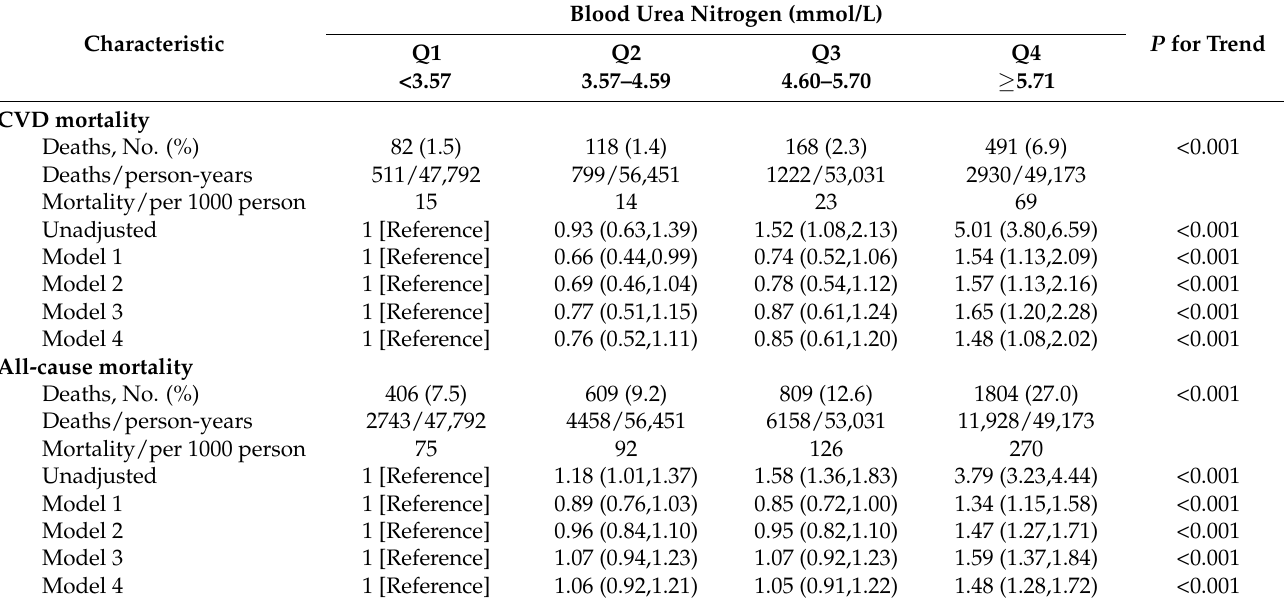
Table 2. Association of the concentration of BUN with CVD and all-cause mortality in U.S. adults aged at least 20